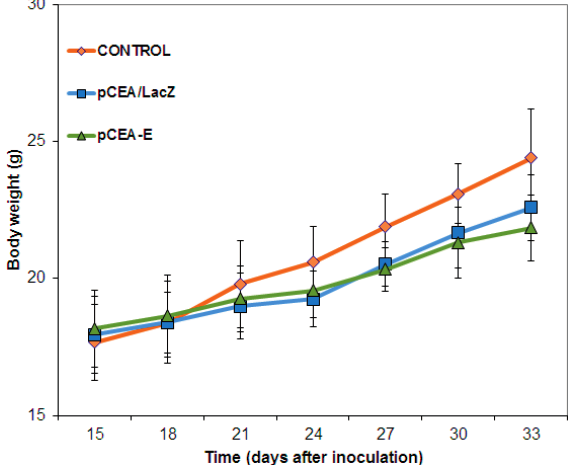
Figure 5. Weight evolution after pCEA - E treatment. The weights of mice bearing subcutaneous MC-38 tumors and treated with pCEA - E were measured. pCEA - E -treated mice experienced a similar weight evolution to that of pCEA - LacZ -treated and untreated mice (control). Data represent the mean value ±